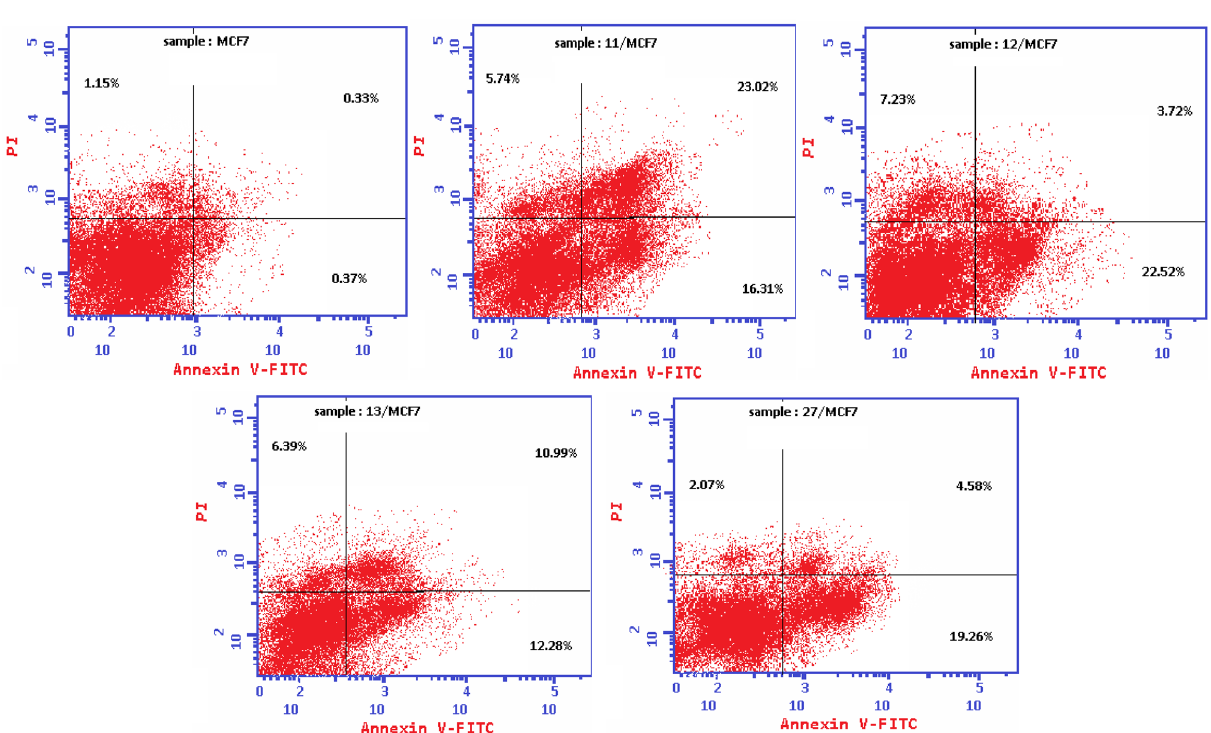
Figure 10. Annexin V-FITC/PI double staining to detect apoptosis in MCF-7 cells after treatment with vehicle control and the newly synthesised compounds; 11, 12, 13 and 27